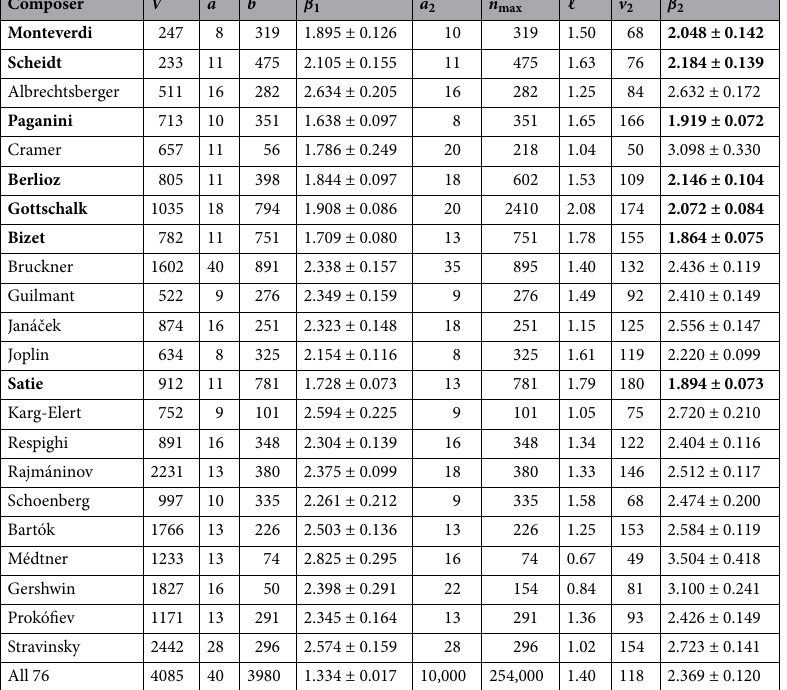
Table 2. Results of the double power-law fit when this fit is rejected, either because the truncated power-law regime has a too short range or because there are not two different power-law regimes (case of non-overlapping fitting ranges is not included, except for the global dataset) 58 . The simple power law fit is accepted (with β = β 2 ) for all composers but one (Bruckner, for which a pl = a 2 = 35 ). The number of orders of magnitude of this fit is given by ℓ = log 10 ( n max / a 2 ) . The number of types included in the fit is v 2 . The uncertainties in β 1 and β 2 are given by the standard deviation of the maximum likelihood estimation. The rest of variables are explained in the main text. The Zipfian subcases ( 1.8 ≤ β ≤ 2.2 ) are marked in